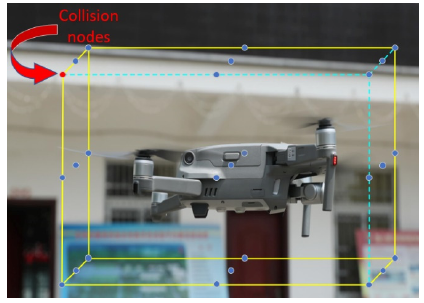
Figure 5. Ring nodes of UAV.